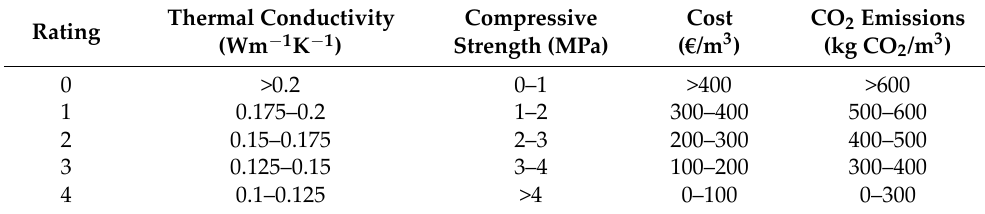
Table 4. Rating of